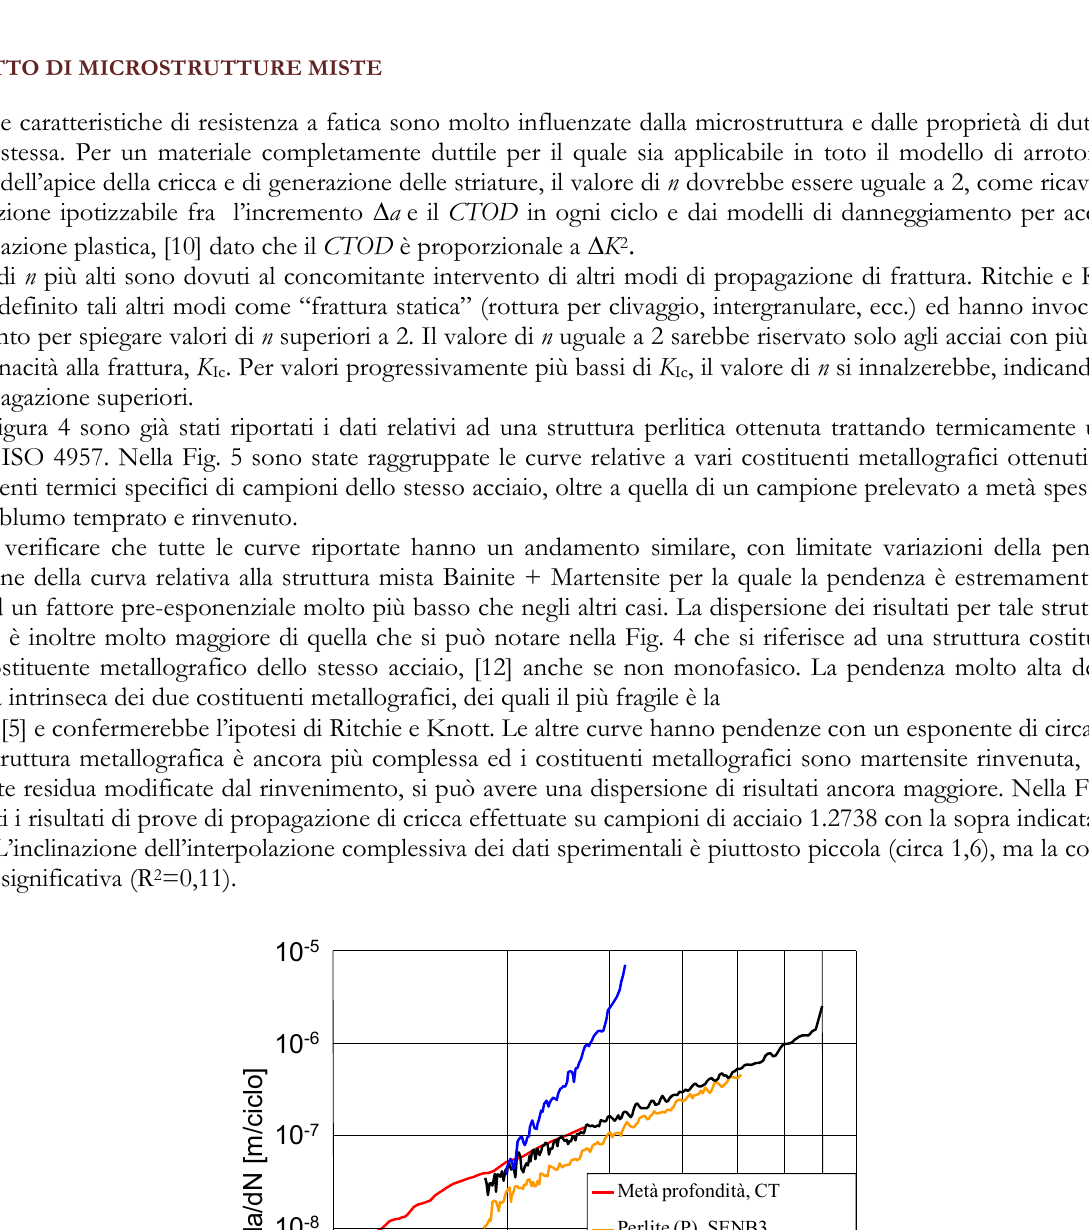
Figure 5: 1.2738 steel: SENB3 testpieces heat treated to yield the microstructures indicated as P (pearlite), TM (tempered martensite), and BM (bainite and martensite); propagation rate diagrams obtained by increasing K Imax . Comparison with results obtained by specimens cut a mid depth (Metà profondità) of a large bloom quenched and tempered (lower bainite modified by tempering, residual austenite transformed during tempering, sparse zones of ultrafine pearlite); R =